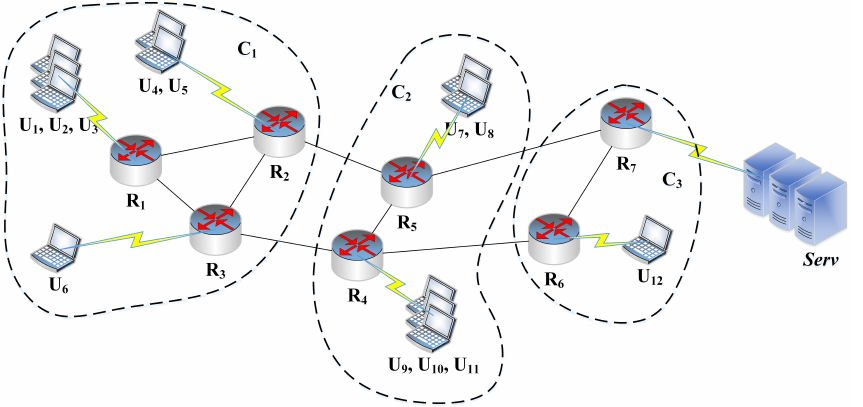
Figure 1. An illustration of network clustering and the caching